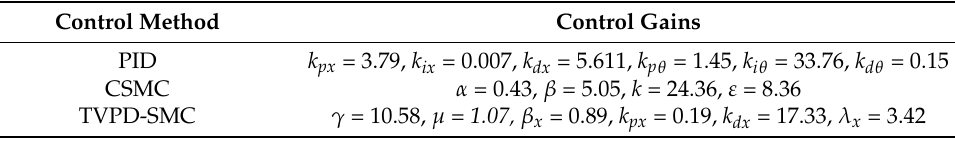
Table 2. Control Gains.